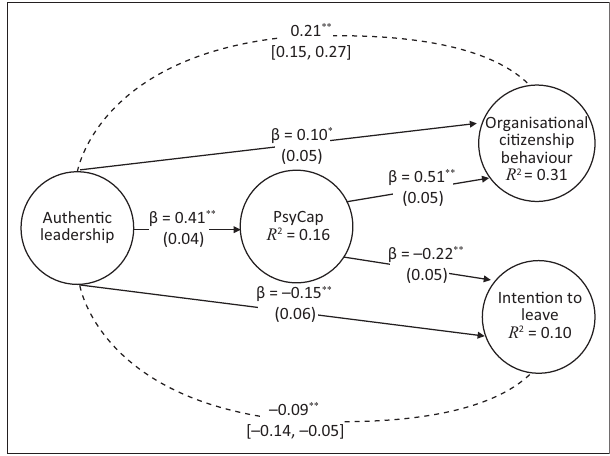
TABLE 1: Descriptive statistics, correlations and reliabilities.